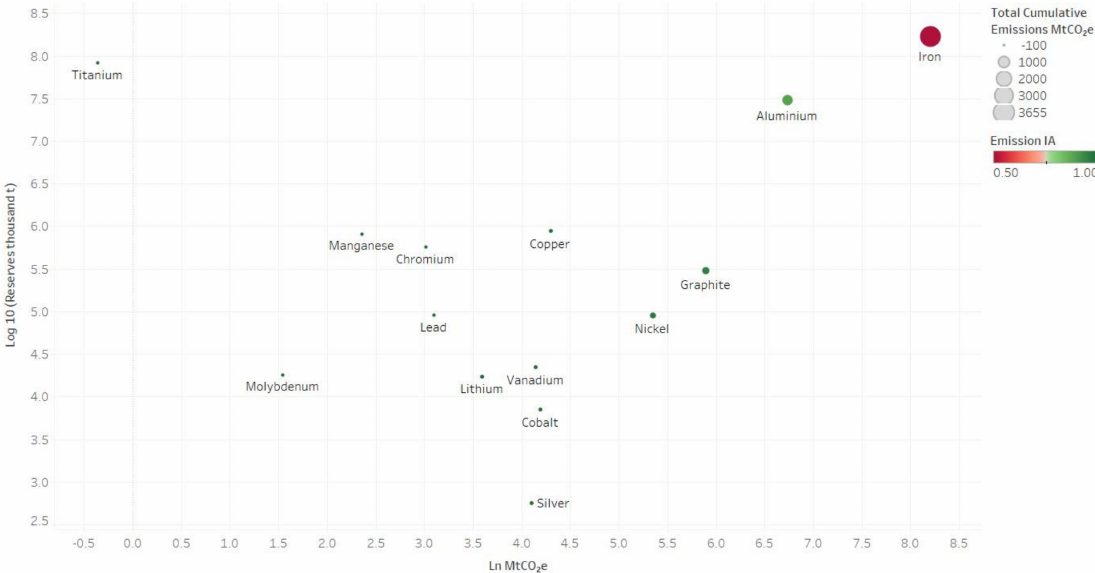
Figure 6. Bi-logarithmic scatterplot of CO 2 emissions versus reserves. Emission IA is shown by colour; symbol size corresponds to the total cumulative emission of carbon